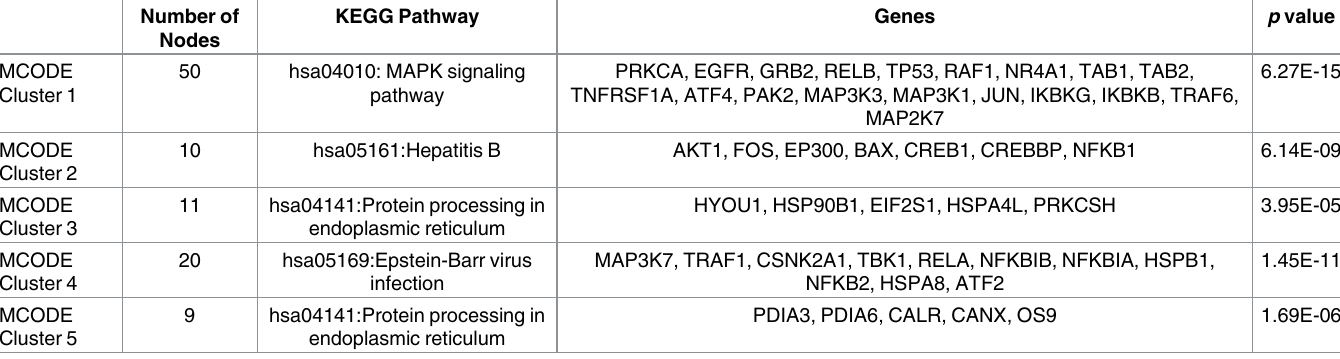
Table 4. KEGG pathways of intersection network and each MCODE cluster by